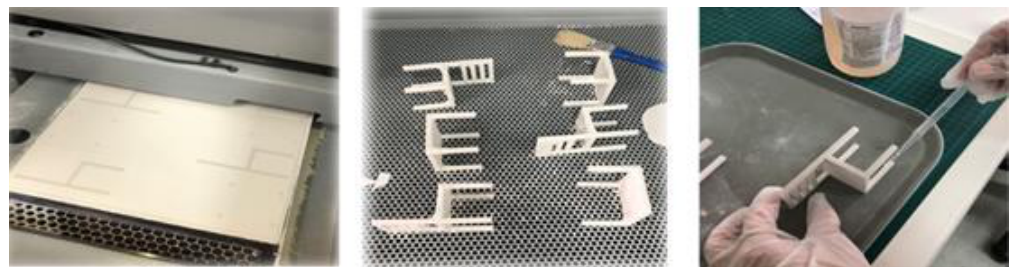
Figure 5. Table and chair 3D models with different wall thickness